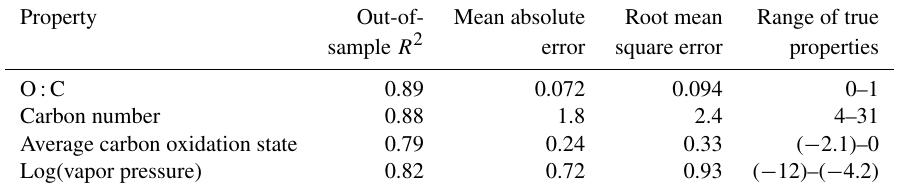
Table 2. Performance metrics for random-forest-based modeling of chemical properties of the external standard test set. Range of true properties units in units of the property O:C, in unitless atom number:atom number, carbon number in atom number, average carbon oxidation state in mean charge, and log(vapor pressure) in log(atm).